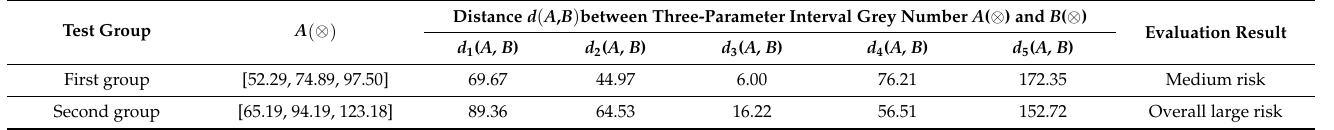
Table 9. Evaluation results of three-parameter interval grey number decision-making.